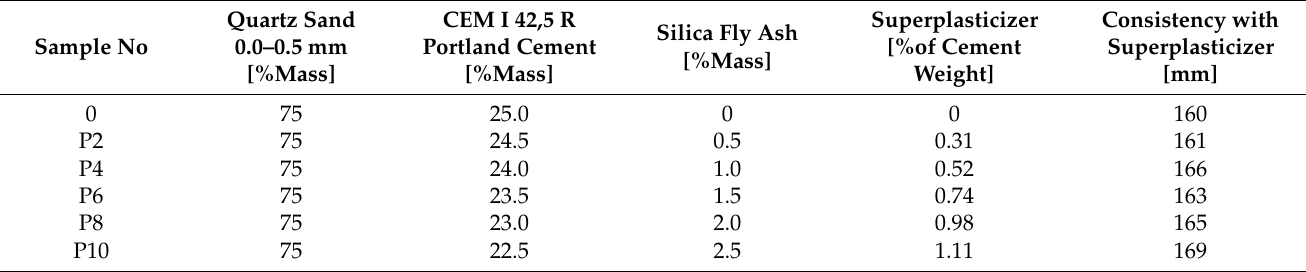
Table 6. Composition of samples modified with silica fly ash.